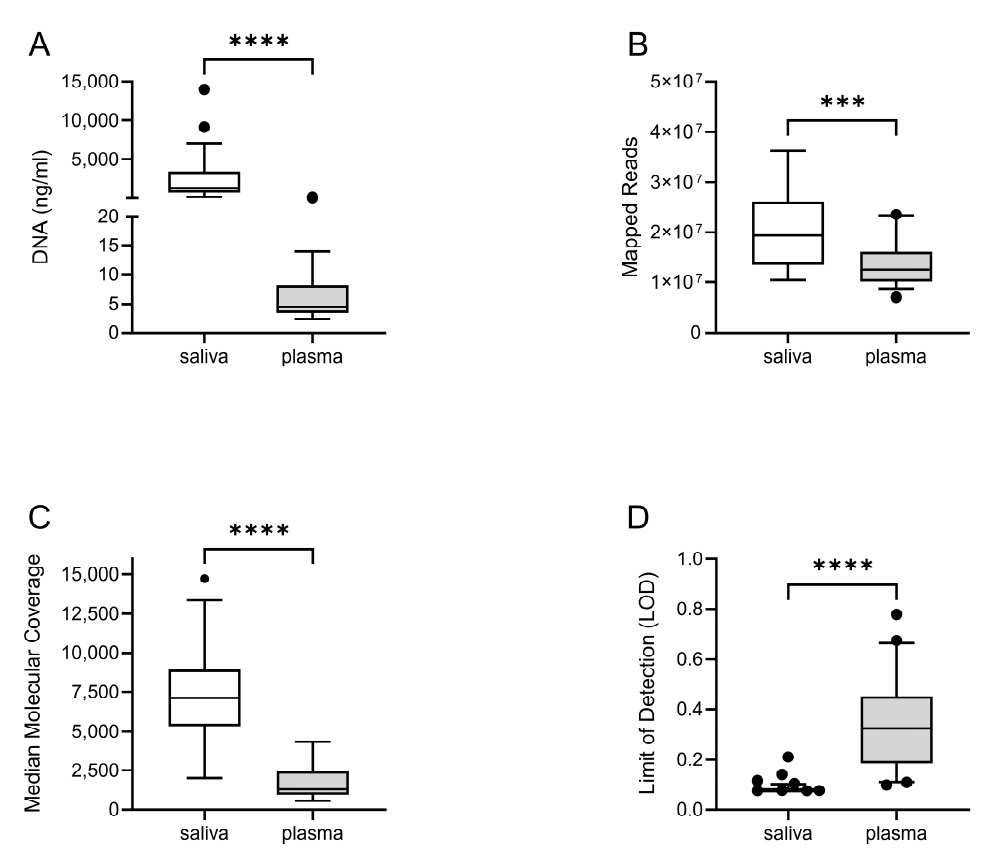
Figure 2. Sequencing performance in saliva and plasma. ( A ) The concentration of DNA purified from saliva was significantly higher than that obtained in plasma, as expected. The total number of mapped reads ( B ) and the median molecular coverage ( C ) showed a better sequencing performance of saliva versus plasma. Consequently, the median limit of detection (LOD %) across targets was lower in saliva ( D ), thus allowing detection of mutations at reduced frequencies in saliva to be more likely. ***: p -value < 0.001; ****: p -value < 0.0001.